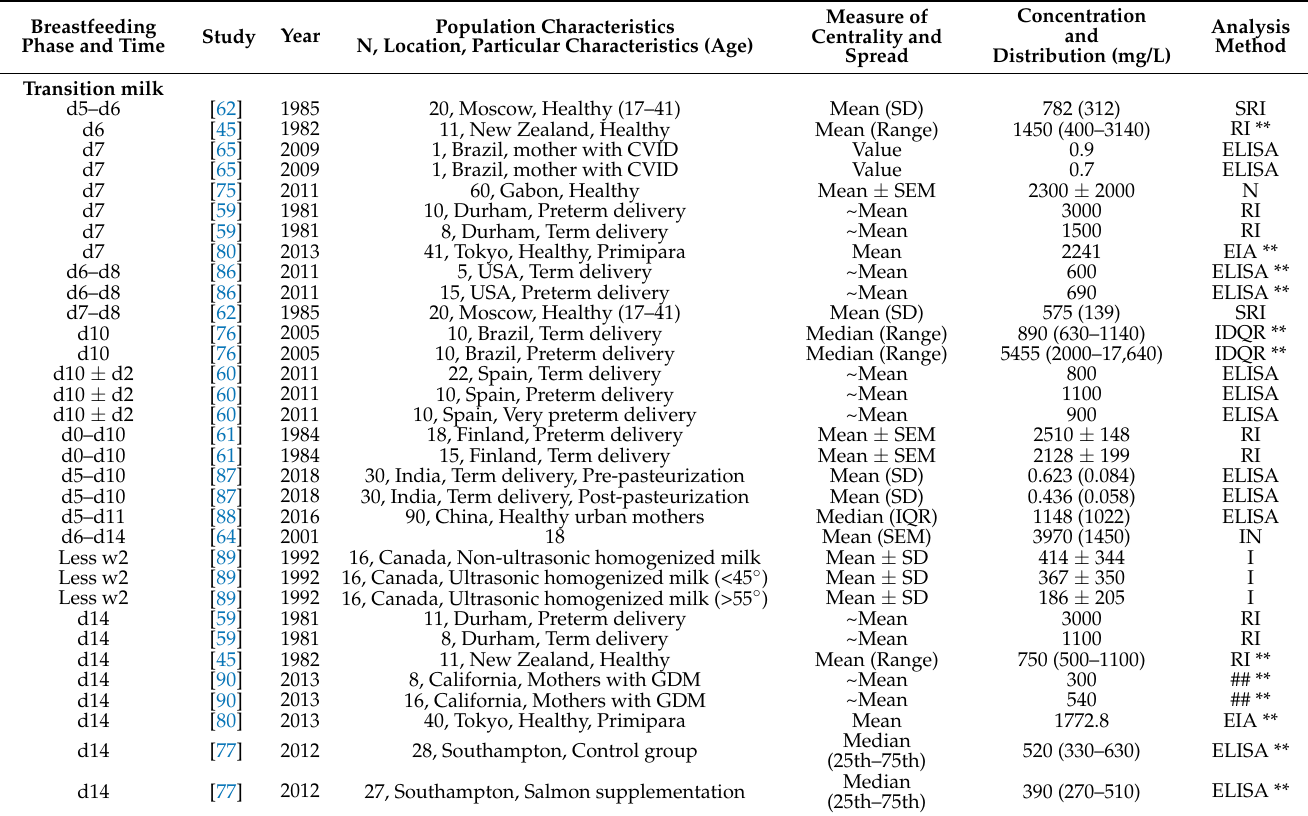
Table 2. IgA in transition